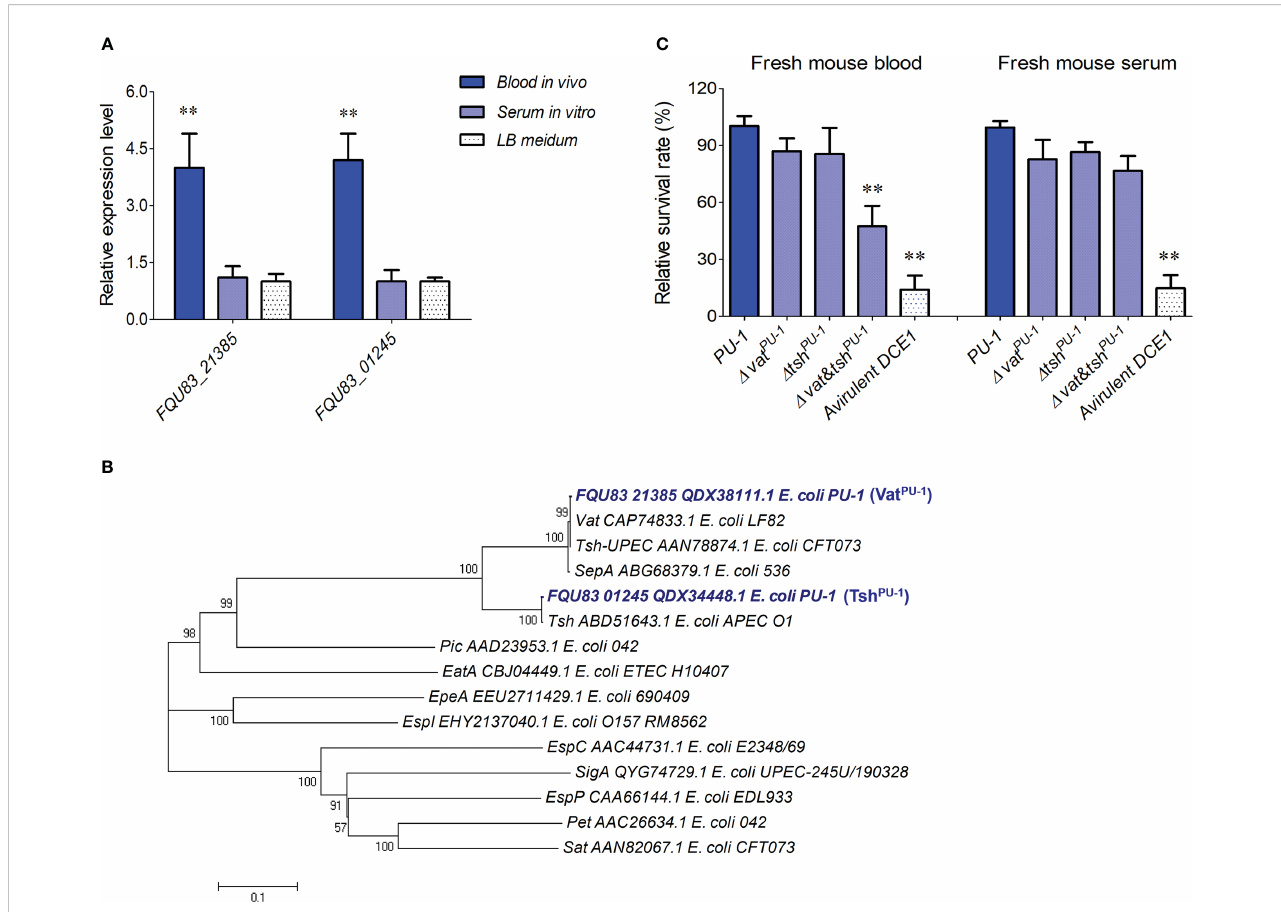
FIGURE 2 Identi fi cation of two serine protease autotransporters as the potential facilitators for optimal blood infection in strain PU-1. (A) The transcriptional changes of indicated genes in ExPEC strain PU-1 response to host blood and serum. The data were normalized to the housekeeping gene tus transcript. Mean values and SDs of triplicate samples are indicated. Statistical signi fi cance was determined by a two-way ANOVA test based on comparisons with the bacterial cells cultured in LB medium (**P < 0.01). (B) Phylogenetic analysis of SPATEs from E coli . A neighbor-joining tree (bootstrap n = 1000; Poisson correction) was constructed based on a ClustalW alignment of the amino acid sequences of SPATEs using the MEGA software version 5.0. (C) Incubations of indicated bacterial strains within fresh blood and serum. The survival rates were calculated by measuring the bacterial counts. The porcine ExPEC strain DCE1 from phylogenetic group A were used as a control here. Statistical signi fi cance was determined by a one-way ANOVA test based on comparisons with the wild-type group (**P <